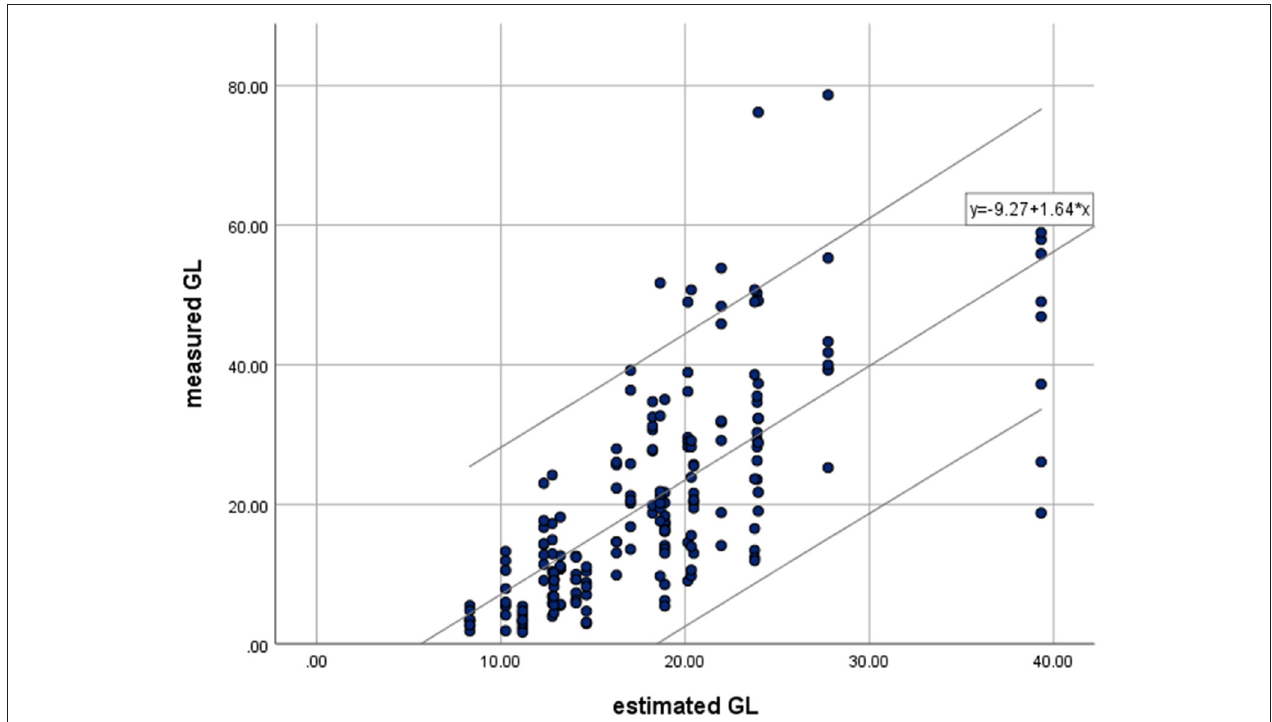
FIGURE 2 | Relationships between means of measured glycemic load (GL) and estimated glycemic load (eGL) for available processed food by simple linear regression. Regression were made for all test meals ( • and - : R ² = 0.507, P = 0.000). Values of parameter